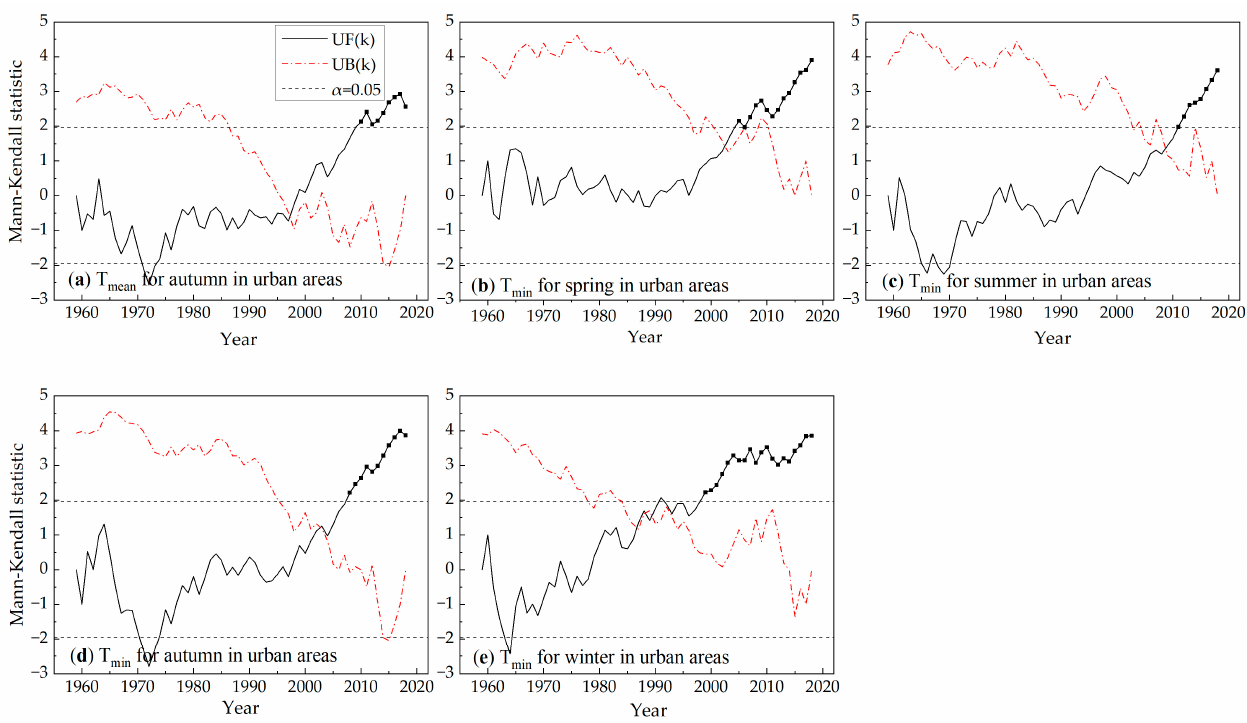
Figure 6. The Mann–Kendall statistic curves during the period of 1959–2018: ( a ) mean temperature for autumn in urban areas; ( b ) mean daily minimum temperature for spring in urban areas; ( c ) mean daily minimum temperature for summer in urban areas; ( d ) mean daily minimum temperature for autumn in urban areas; ( e ) mean daily minimum temperature for winter in urban areas.